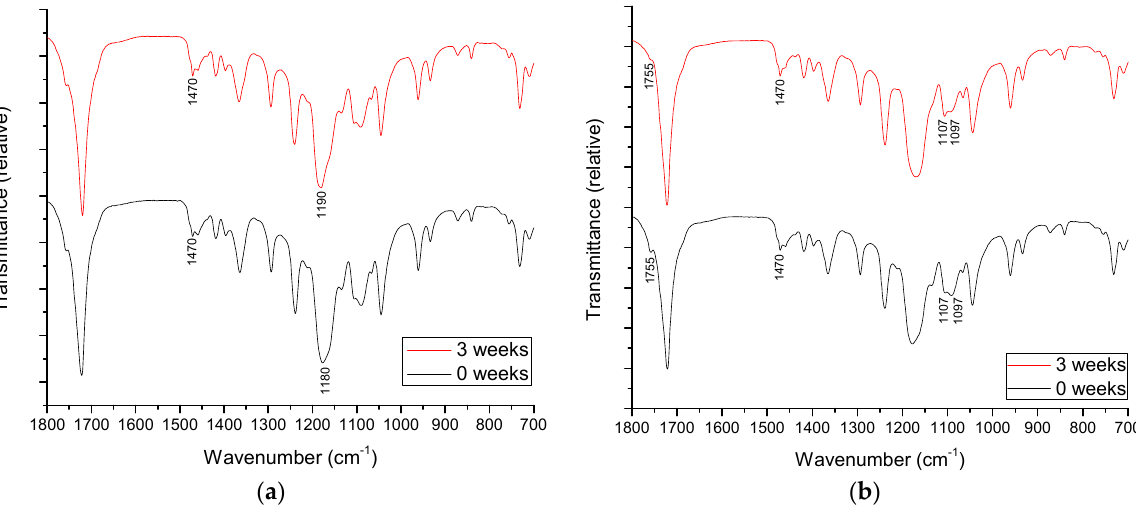
Figure 9. FTIR-ATR spectra of aged PCL/PLA/CF blends: ( a ) 100/0/0 and ( b ) 100/0/3.0.